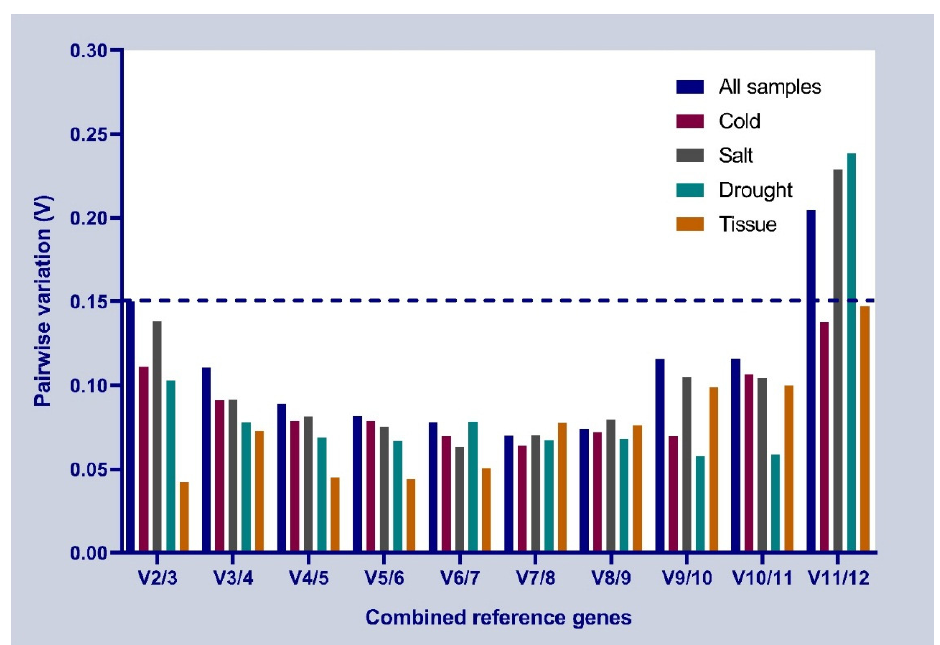
Figure 4. Pairwise variations value under different conditions based on a geNorm analysis. Table 2. Stability analysis of candidate reference genes based on NormFinder